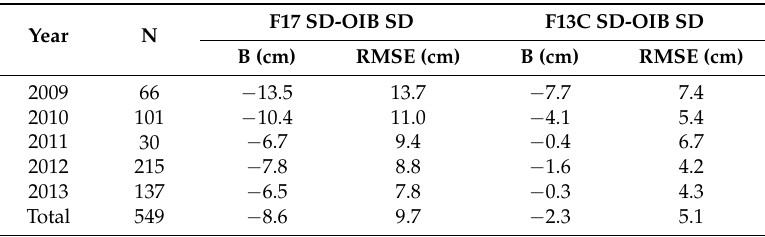
Table 5. Bias (B) and root mean square error (RMSE) of F17 SD minus OIB SD (F17 SD-OIB SD) and